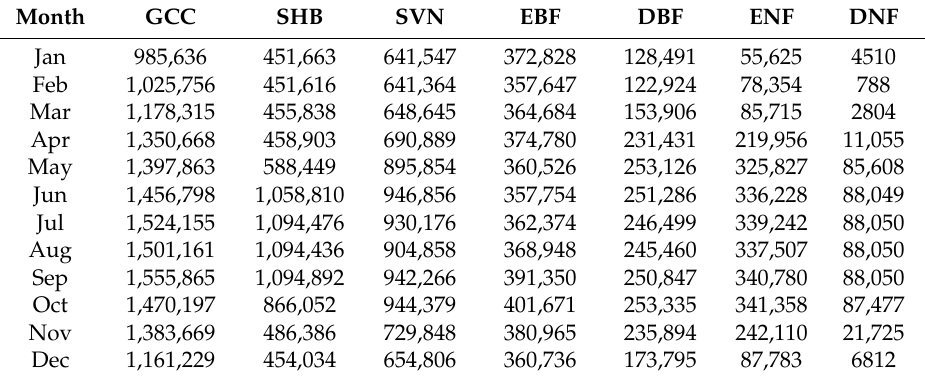
Table 3. The number of pixels to calculate the mean values and standard deviationsacross different biomes for 12